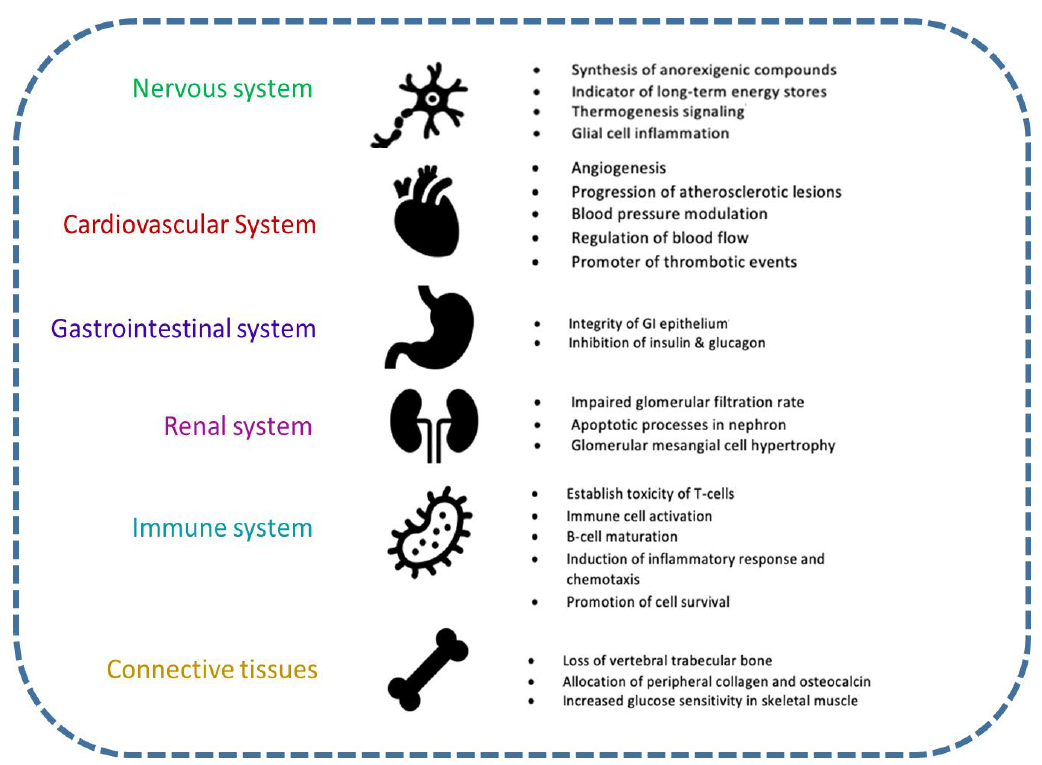
Figure 1. An illustration of the broad effects of leptin signaling within the human body. The role of leptin as an anorexic agent is well known. The role of leptin in regulating various physiological systems under normal and pathological conditions are explained here, including cardiovascular, gastrointestinal, renal, immune, and skeletal systems.